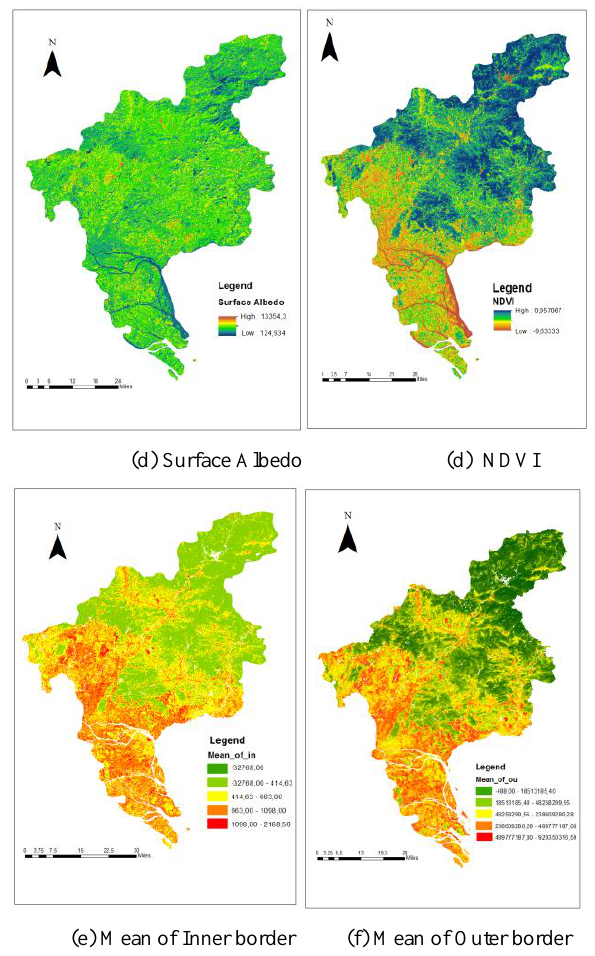
Figure 3. The spectral parameters and climate parameter that were derived from HJ-1B image Table 1. The correlations matrix between all climate and